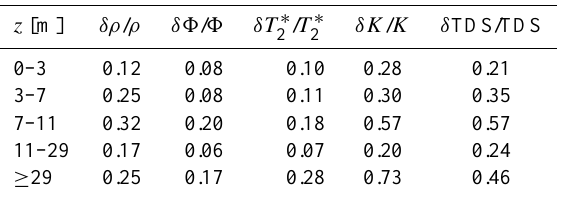
Table 4. Relative uncertainty of all primary and secondary parame- ters from sounding